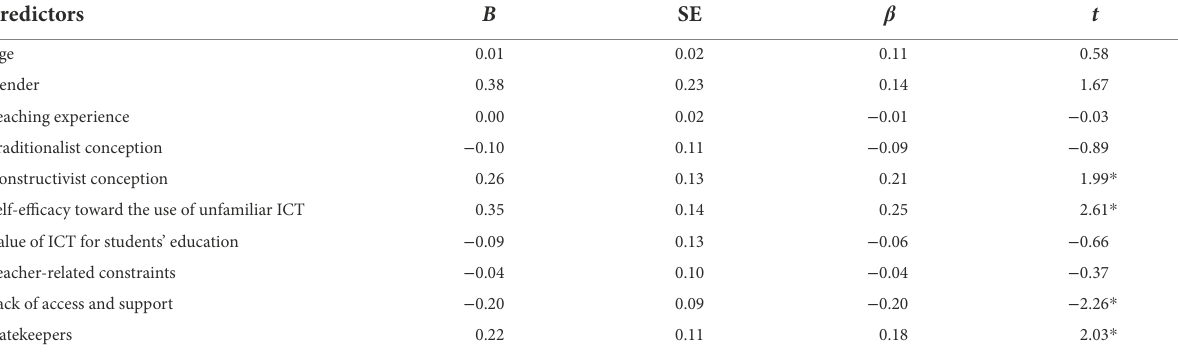
TABLE 3 Final model with all main effects of age, gender, teaching experience and ICT’s and teaching’ related variables on teachers’ effective use of ICT in their classroom.